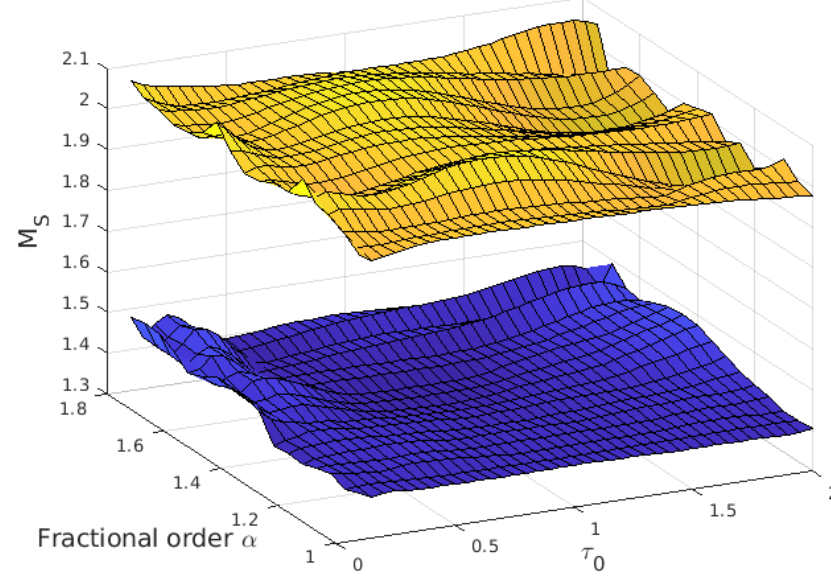
Figure 4. Evaluation of M S using the FOPID controller.